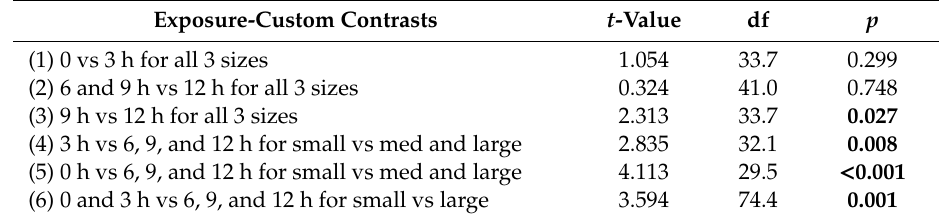
Figure 1. Mass-specific respiration rates (MO 2 (mg O 2 g − 1 h − 1 )) (mean ± 1 one se) across the three body- size classes during 12 h of moderate exposure to hypoxia (20% air saturation). Respiration was measured for all subjects at a normoxic reference (0 h) and at four 3-h hypoxia exposure intervals (3, 6, 9, and 12 h). Solid grey bar represents measurements after 24 h of hypoxia exposure for 20 di ff erent individuals from the recovery experiment. Table 1. Custom and interaction contrasts for the exposure experiment (see text for explicit descriptions of time intervals) (bold p <